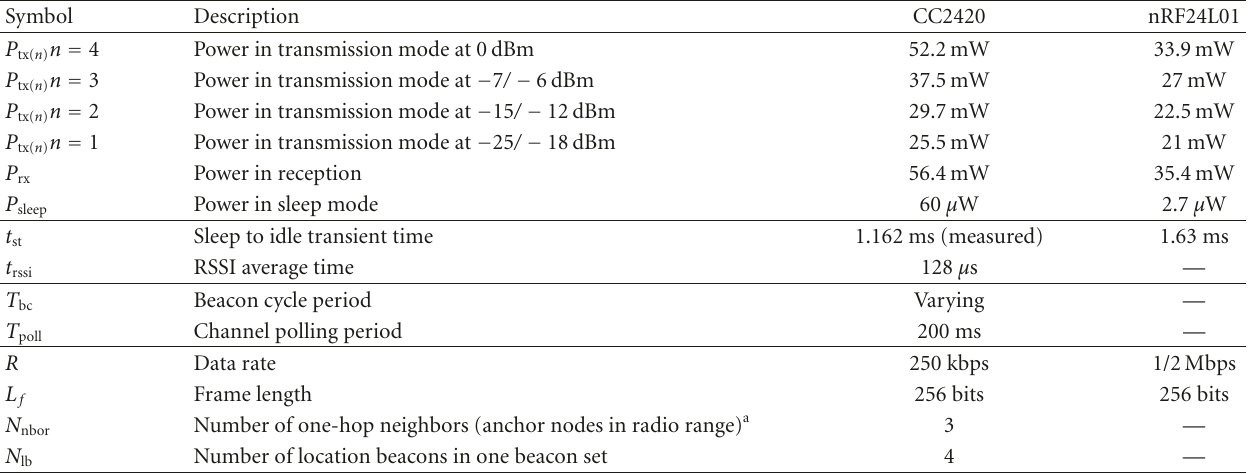
Table 1: Symbols, descriptions, and defined values for MAC power consumption analysis.